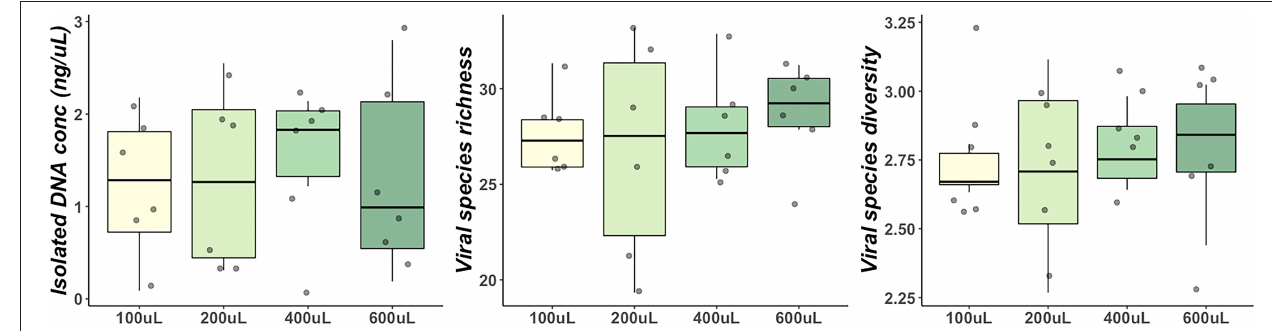
diversity ( Supplementary Table 4 , Supplementary Figure 5